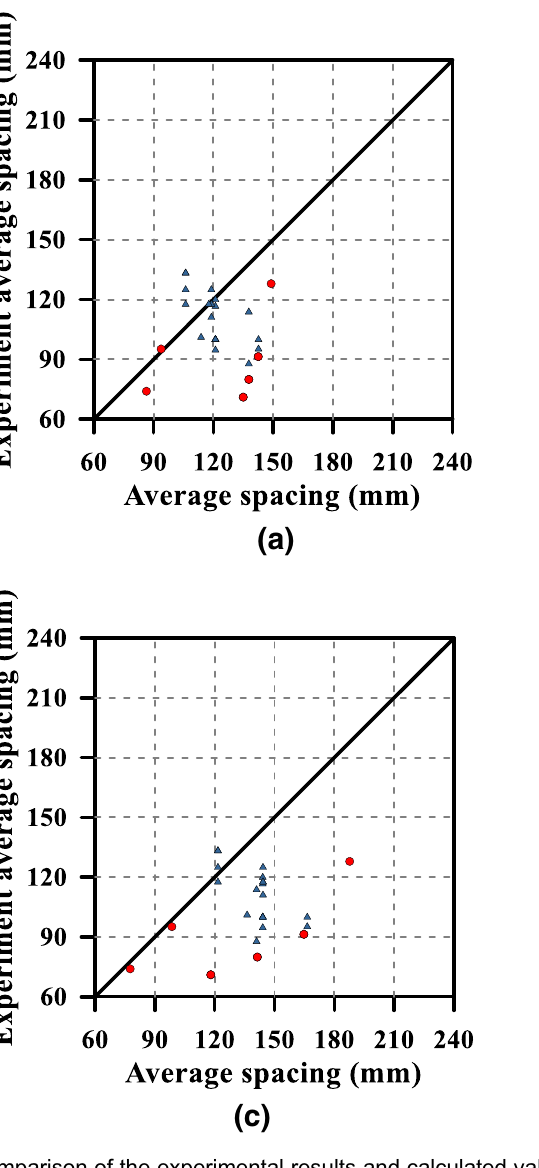
Fig. 15 Comparison of the experimental results and calculated values using various specifications for the average flexural crack spacing. a ACI 318 (2014), b CEB-fib Model (2010), c AIJ (2010), and d JSCE (2007) (Circle points are the specimens in this work; triangle points are the specimens in the references (Chiu et al. 2014,